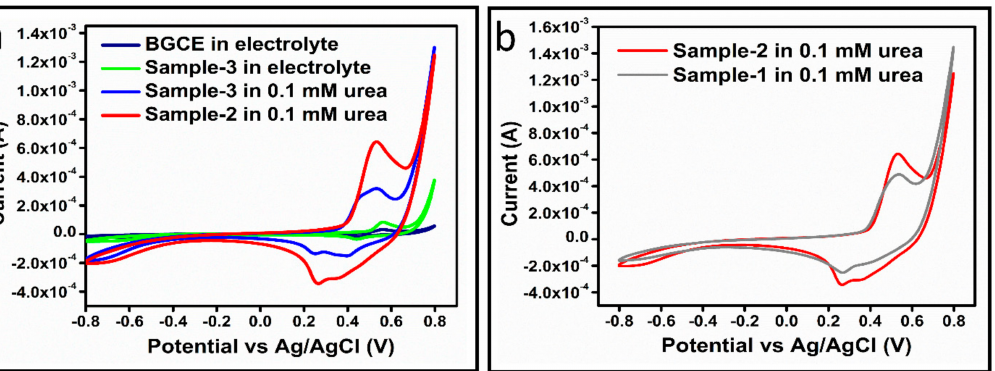
Figure 2. ( a ) CV curves of bare GCE (BGCE) and modified glassy carbon electrode (MGCE) with Sample 3 NiCo 2 O 4 nanomaterial, Samples 1 and 2, 50 mV/s in the presence of 0.1 mM urea and only in 0.1 M NaOH, ( b ) CV curves of Samples 1 and 2 based NiCo 2 O 4 nanomaterial, at 50 mV/s in the presence of 0.1 mM urea prepared in 0.1 M NaOH.